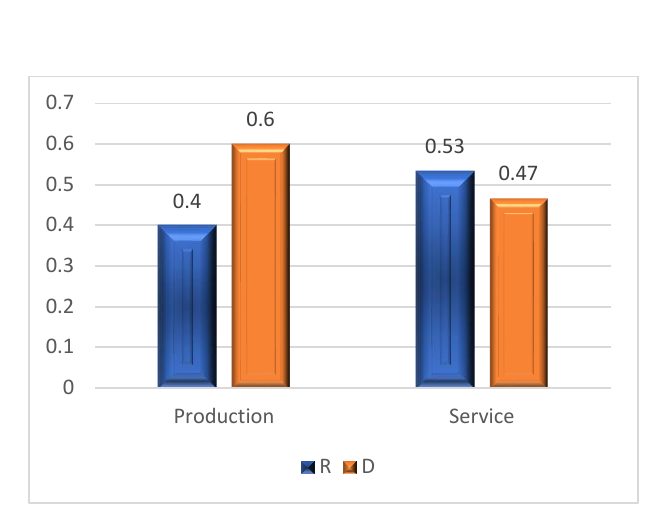
Figure 3. Robustness and debility of the product and service business.